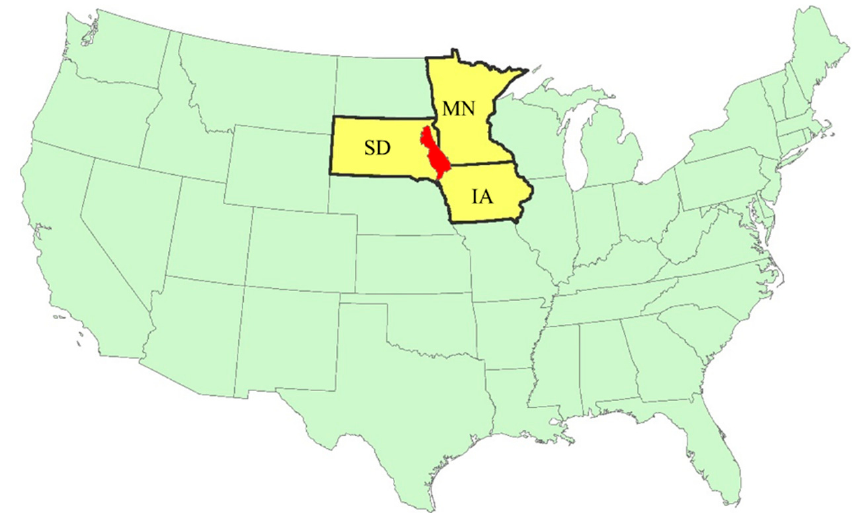
Figure 1. The location of the watershed in Northern Great Plains of USA. (Sources: satellite image from Google TM Earth, 2018).